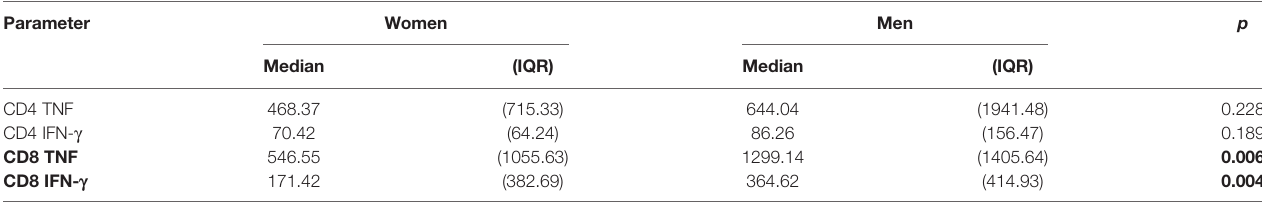
TABLE 4 | iMFI for TNF and IFN- g between biological sex groups.